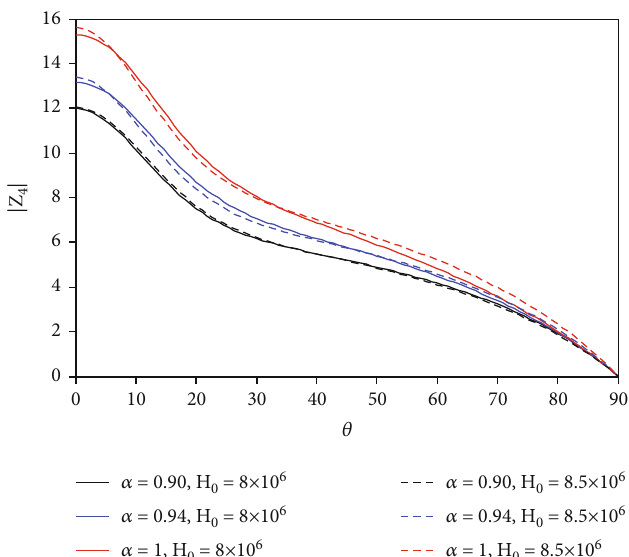
j concerning the angle of incidence θ for various values of the fractional parameter of the 4